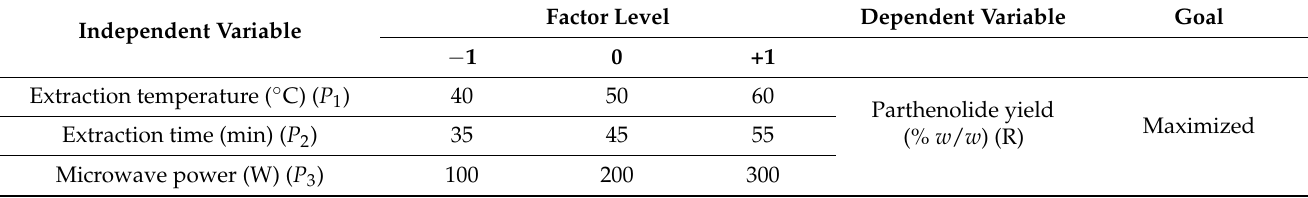
Table 1. Extraction variables selected for Box-Bohnken Design (BBD) optimization.